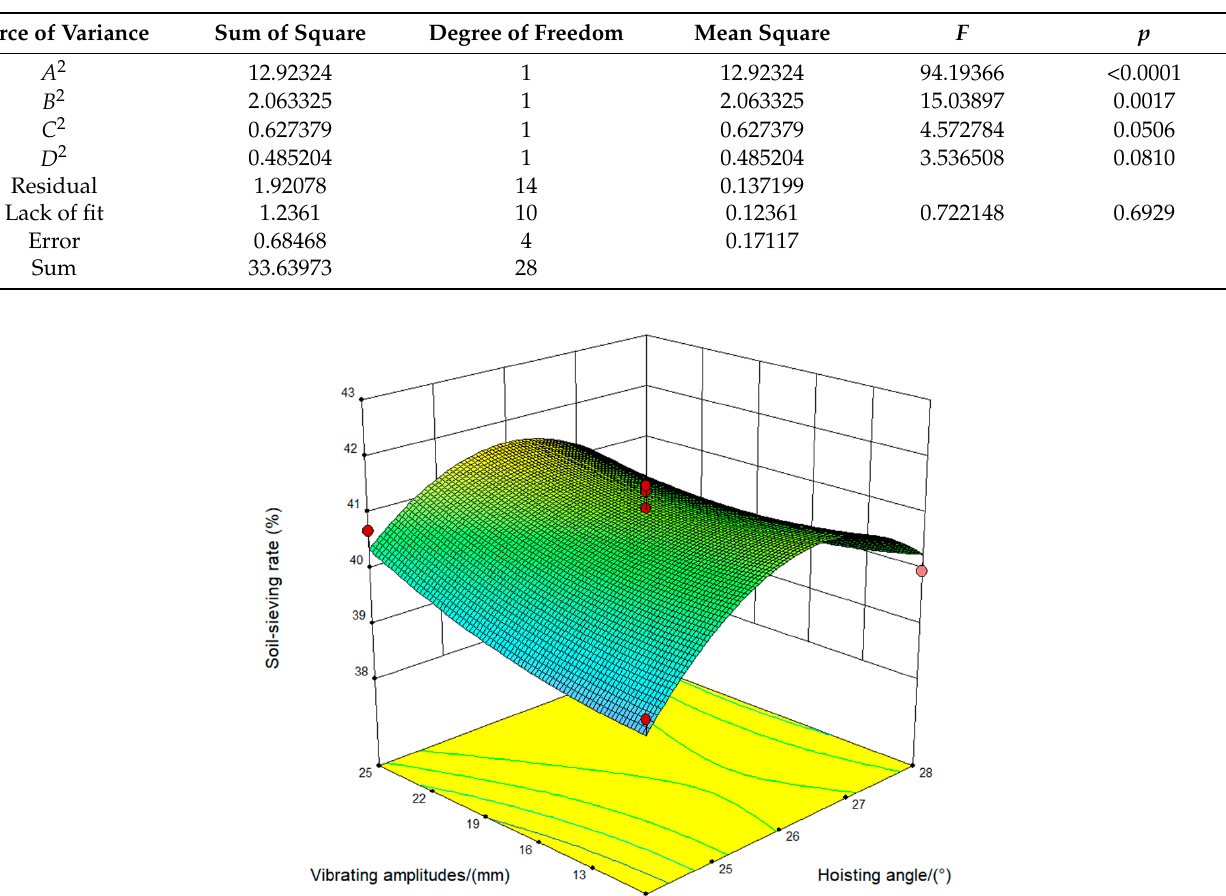
(18) Table 5. Analysis of variance of regression equations. Source of Variance